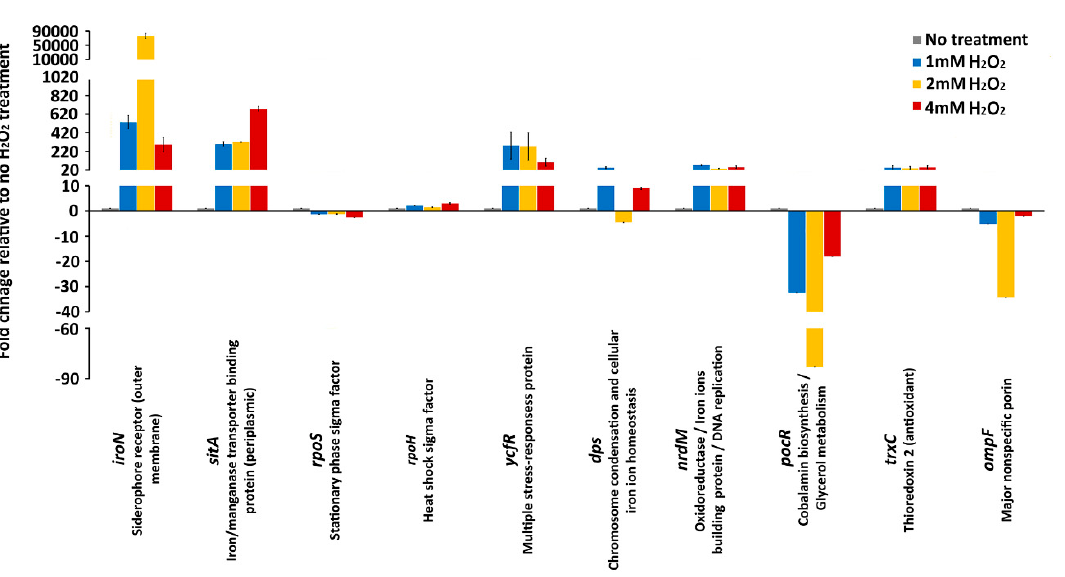
Figure 2. Gene expression. mRNA expression levels of iroN , sitA (iron receptor), rpoS , rpoH (alternative sigma factors), ycfR , dps (stress response), nrdM , trxC (antioxidant), ompF (nonselective uptake), and pocR (anabolism) during no H 2 O 2 treatment, 1 mM, 2 mM, and 4 mM H 2 O 2 treatments. Values on the y-axis are relative expression levels (fold change) normalized against the level in the no H 2 O 2 treatment group. The data correspond to the mean values of three biological replications. Error bars correspond to the standard deviation.